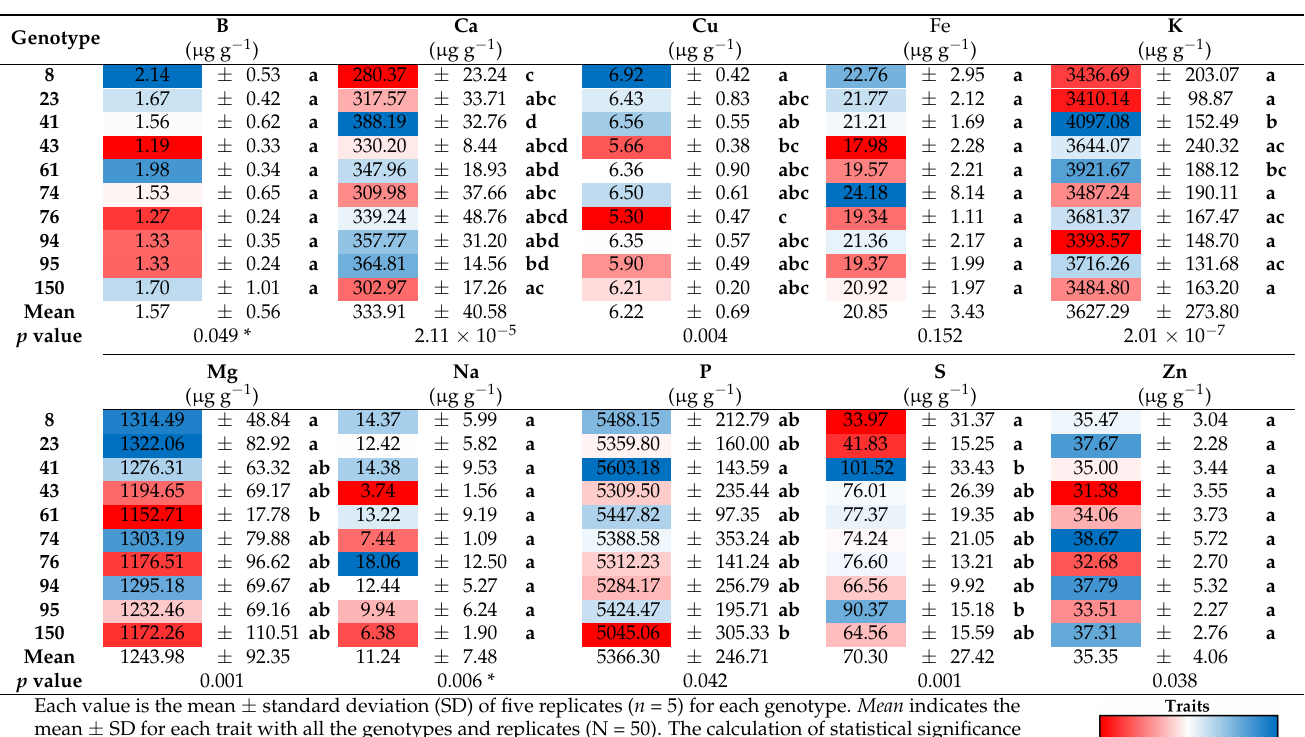
Table 3. Mineral nutrient (B, Ca, Cu, Fe, K, Mg, Na, P, S and Zn) concentrations of 10 wheat genotypes grown under elevated CO 2 and high